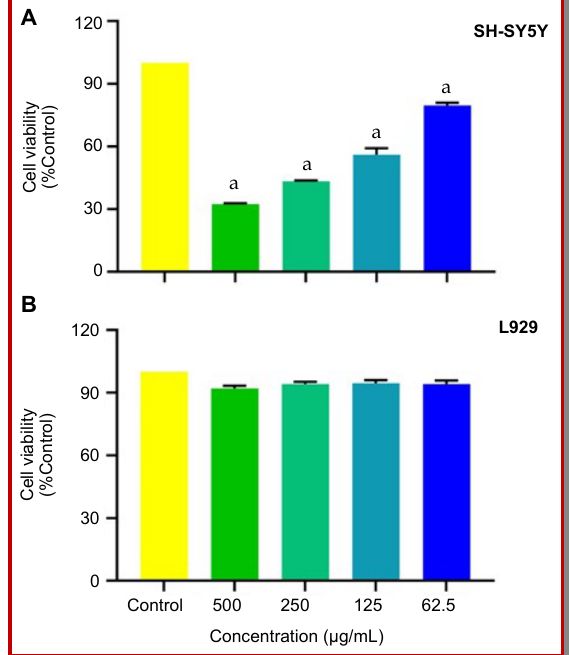
Figure 1: The antiproliferative effects of β -glucan on SH-SY5Y cells (a) and L929 cells (b). The findings are calculated as a percentage of viable cells versus control. The results are presented as the mean ± SEM of three samples. a p < 0.01 as compared to the control group